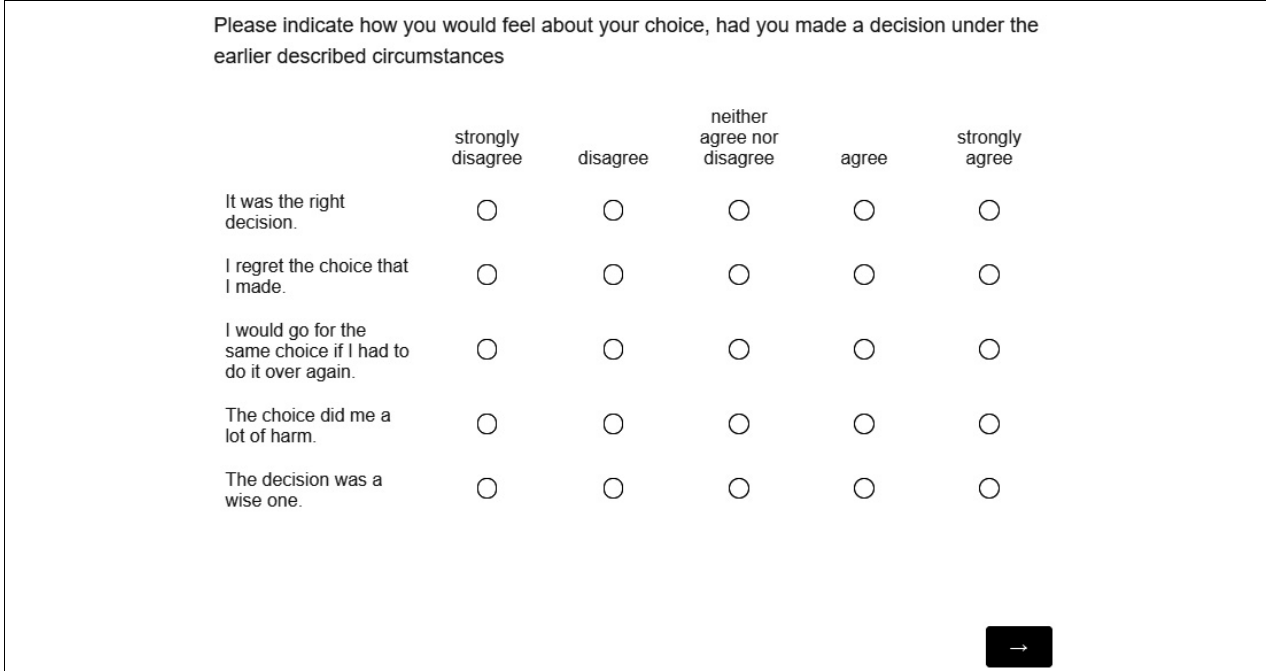
FIGURE B2 | Expected satisfaction questionnaire. Question two and four are